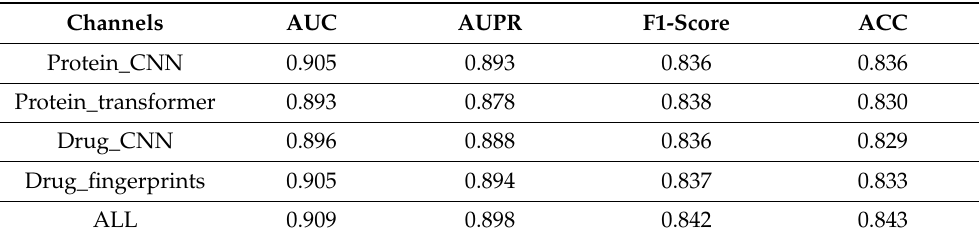
Table 6. Ablation experiments on 100% BindingDB